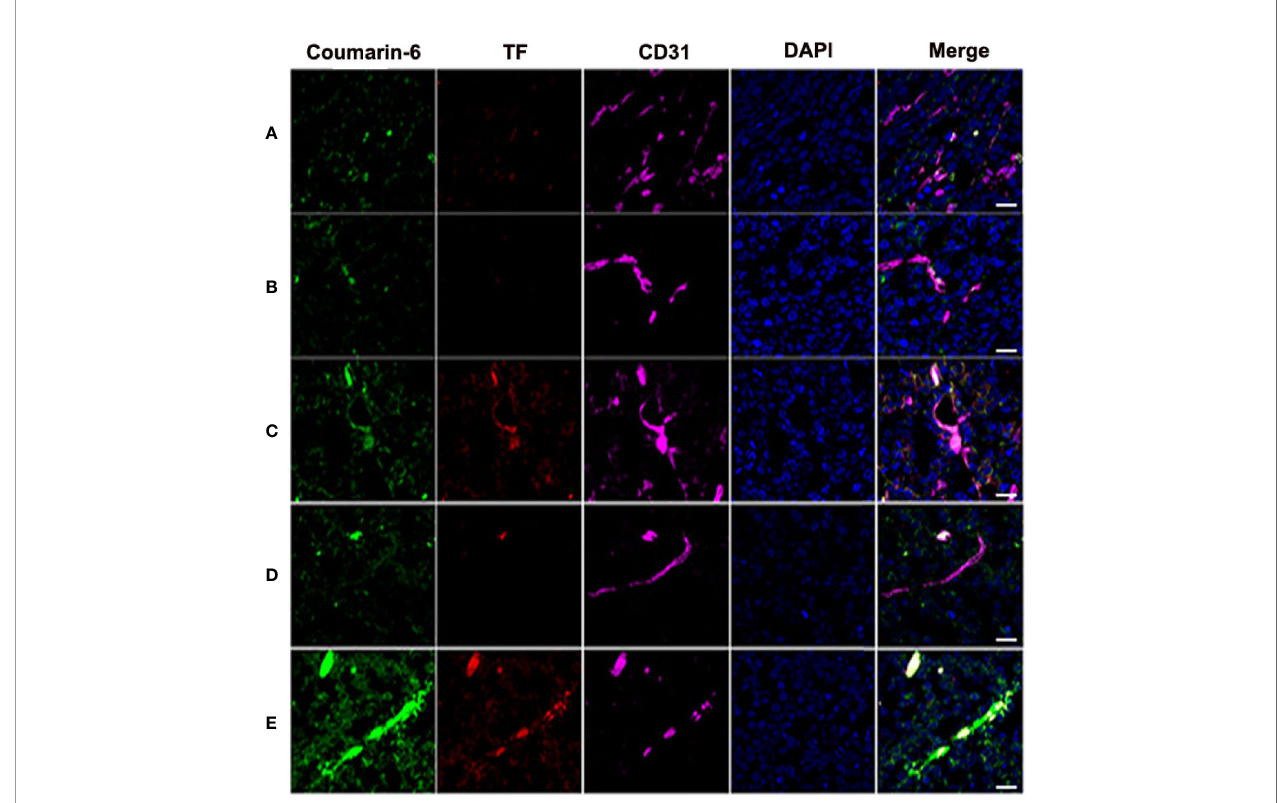
FIGURE 6 | Tumors were harvested for inspection at 24 h post-PDT to estimate nanoparticle accumulation and TF expression in tumor vessels. (A) Coumarin-6- ENPs; (B) Coumarin-6-NPs plus PDT; (C) Coumarin-6-ENPs plus PDT; (D) Coumarin-6-CNPs plus PDT; (E) Coumarin-6-CENPs plus PDT. Frozen sections of tumors were stained with rabbit anti-rat TF polyclonal antibody and mouse-derived CD31 polyclonal antibody examined by confocal microscopy. Blue: cell nuclei. Green: coumarin-6-labelled nanoparticles. Red: TF expression. Purple: CD31. (scale bars 20 m